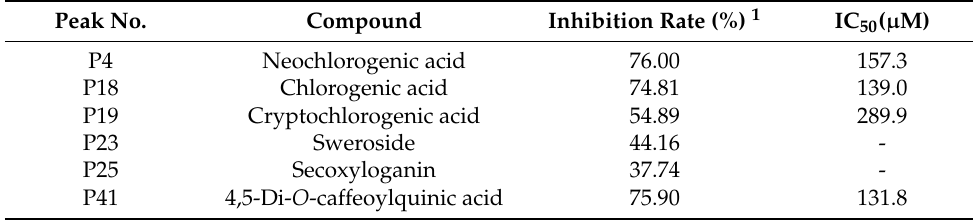
Table 5. NA inhibitory activities of the bioactive compounds. Peak